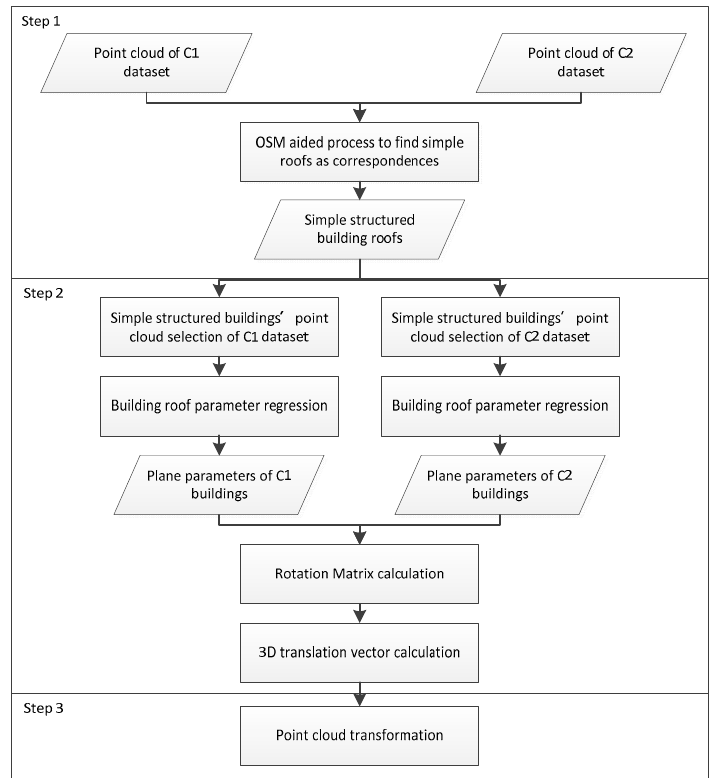
Figure 2. The flowchart of the proposed method.